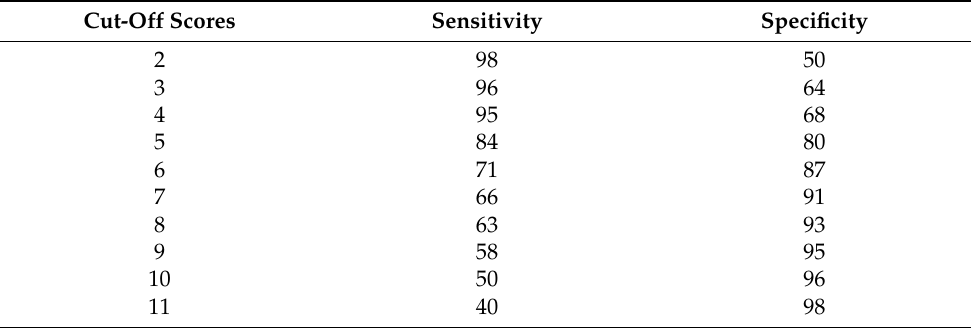
Figure 2. ROC curve plotting MTX intolerance with the questionnaire against the gold standard with cut-off score of 5 in JIA patients. AUC = 0.89 (95% CI, 0.80–0.95). Table 5. Sensitivity and specificity for cut-off scores (2–11 points) on the MISS. the observed variability, as shown in Figure 3. Cut-Off Scores Sensitivity Specificity 2 98